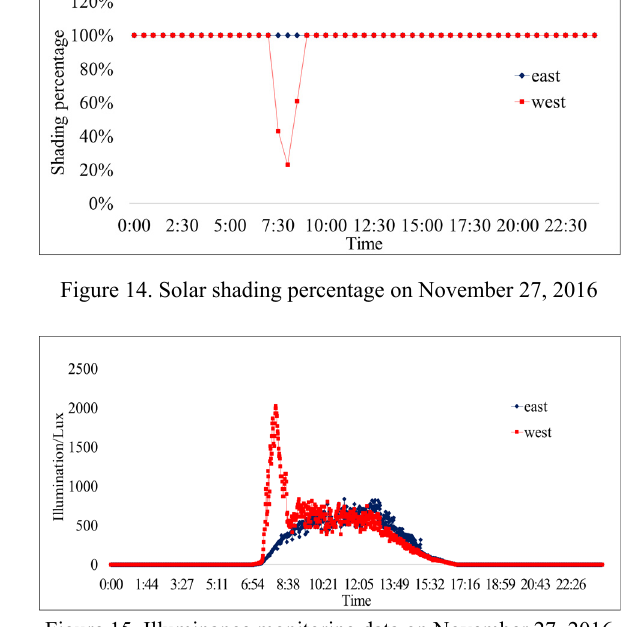
Figure 15. Illuminance monitoring data on November 27,